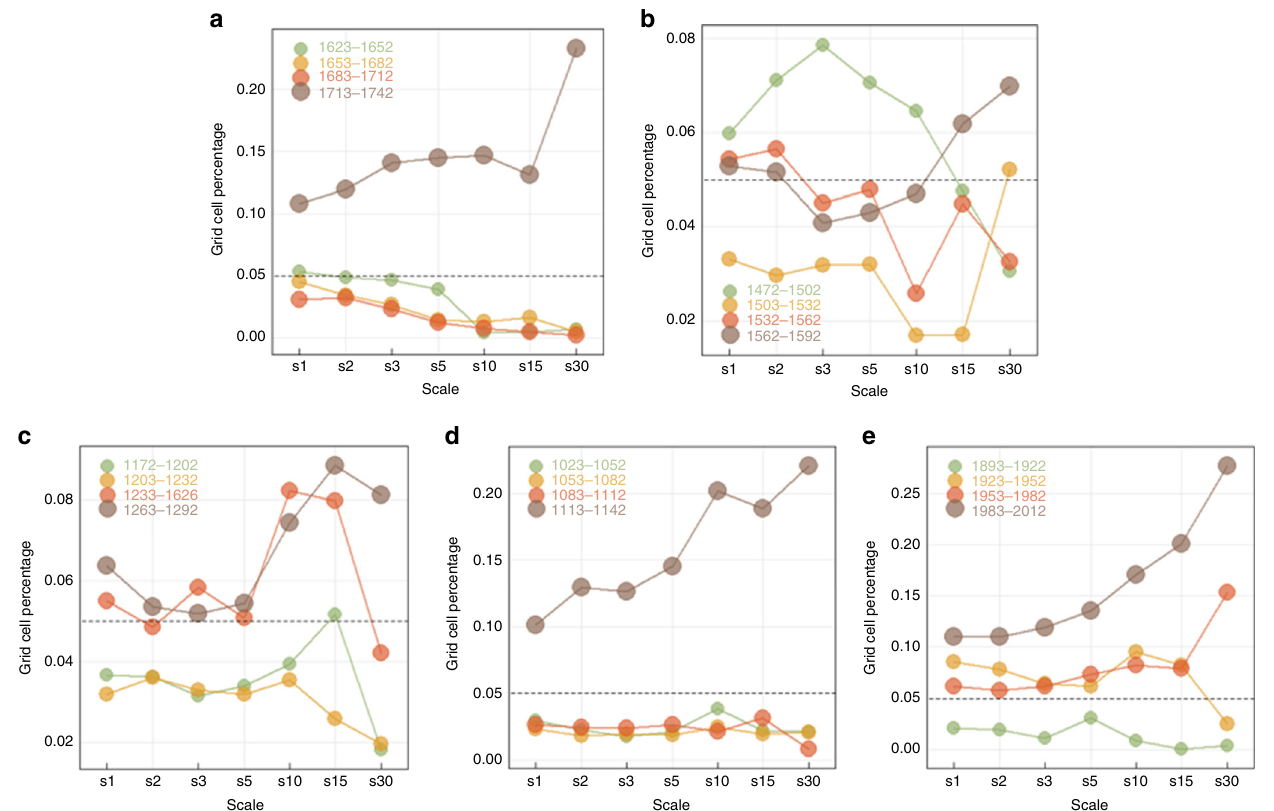
Fig. 5 Cross-scale analysis of major pluvials. Temporal progression per 30-year interval in terms of grid cells percentage; s1 to s30 refer to different temporal scales, e.g., s1 is 1 year, s2 is 2 years, etc. Grey dashed line represents the theoretical quantile value. Each panel corresponds to a different period: a 1623-1742, b 1473-1592, c 1173-1292, d 1023-1142, e